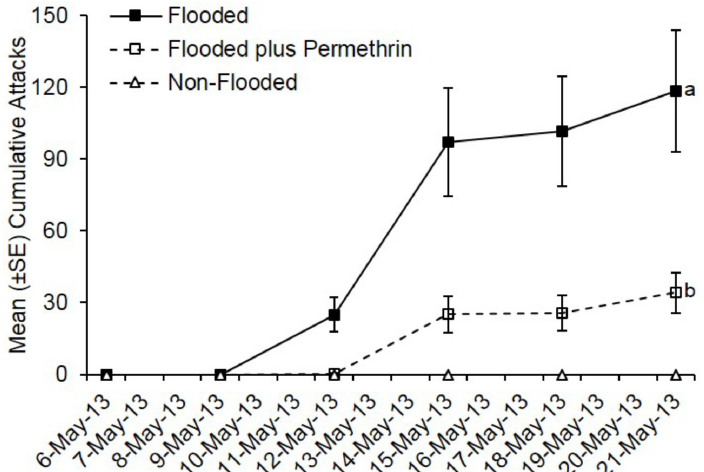
Figure 2. Impact of flood-stress and preventive insecticide treatment on ambrosia beetles attacks